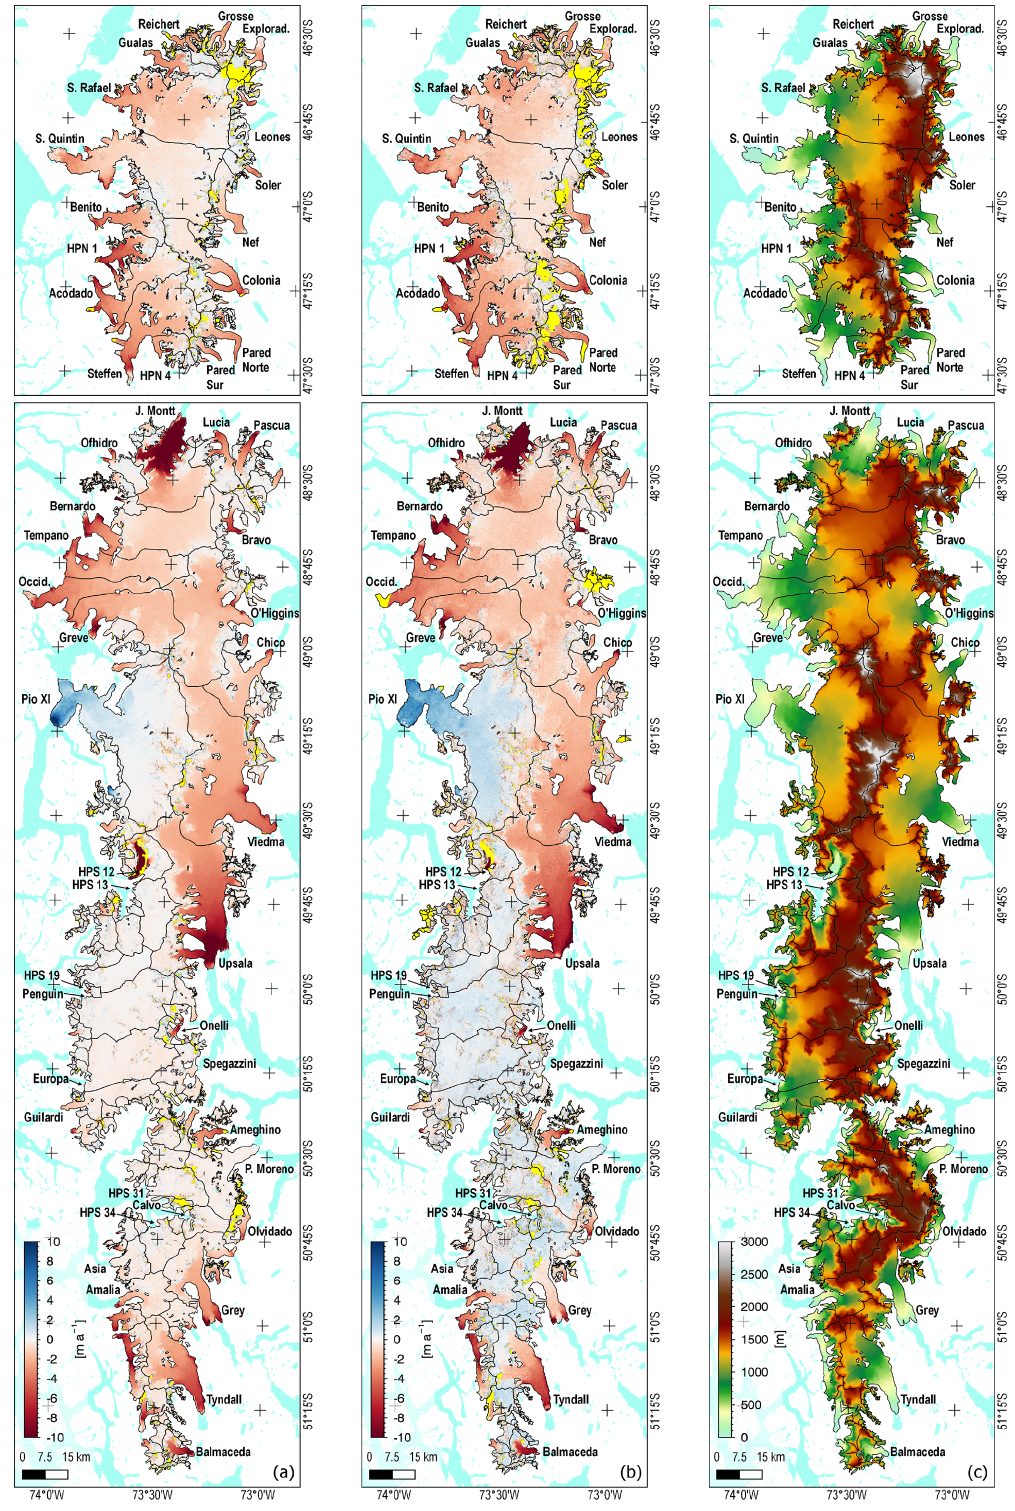
Figure 1. SECR maps of NPI and SPI for the two epochs (a) 2000–2012 and (b) 2012–2016. Unsurveyed areas are marked in yellow. (c) The TDM DEM of 2012 used as reference for the geodetic mass